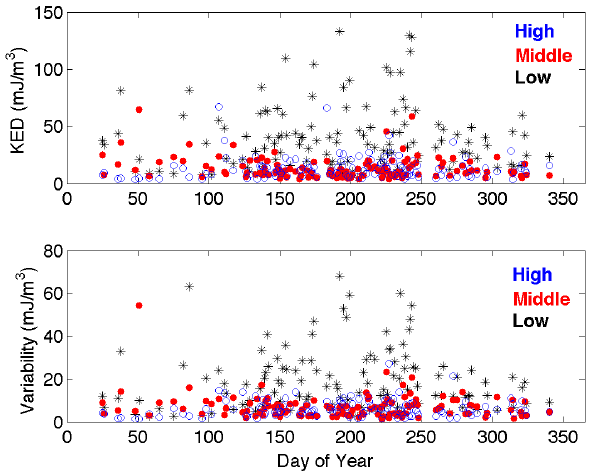
Fig. 8. The top panel shows the nightly kinetic energy density for Figure 8. The top panel shows the nightly kinetic energy density for the composite year for the the composite year for the Low (the upper stratosphere, 30 to 50km; black asterisks), Middle (the lower mesosphere, 45 to 65km; red Low (the upper stratosphere, 30 to 50 km; black asterisks), Middle (the lower mesosphere, 45 to sold circles) and High (the upper mesosphere, 60 to 80km; blue 65 km; red sold circles) and High (the upper mesosphere, 60 to 80 km; blue open circles) regions. open circles) regions. The lower panel shows the geophysical vari- ability of the kinetic energy density during the nightly measurement The lower panel shows the geophysical variability of the kinetic energy density during the nightly period. The statistical error is negligible for the nightly average measurement period. The statistical error is negligible for the nightly average compared to the compared to the geophysical geophysical variability.